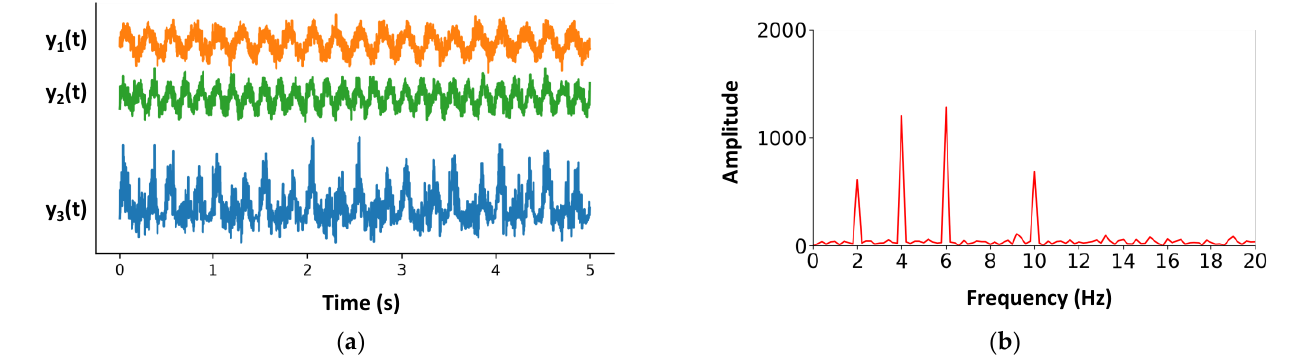
Figure 3. Simple example of IMs . ( a ) The three signals varying over time within 5 s. The signals y 1 and y 2 are sinusoidal signals with Gaussian random perturbations. The frequencies of y 1 and y 2 are 4 Hz and 6 Hz, respectively, and the signal y 3 is the linear superposition of y 1 and y 2 . ( b ) Amplitude of signal y 3 in the frequency domain, which represents the amplitude of each spectral component. The term “fundamental” frequencies denote the frequencies of the input signals (4 Hz and 6 Hz here), and the term IM denotes any sum of the nonzero integer-multiples of the fundamental frequencies (i.e., m × f1 + n × f2, such as 4 + 6 = 10 Hz and 6 − 4 = 2 Hz).